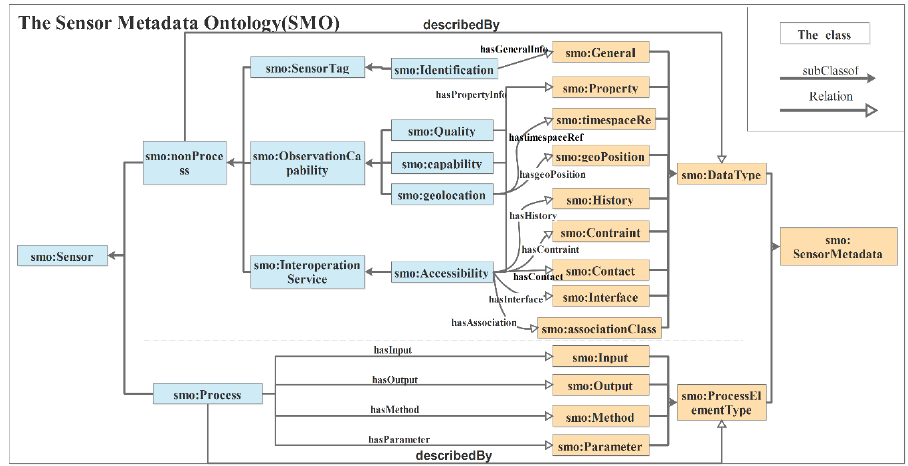
Figure 2. The structure of the sensor metadata ontology.